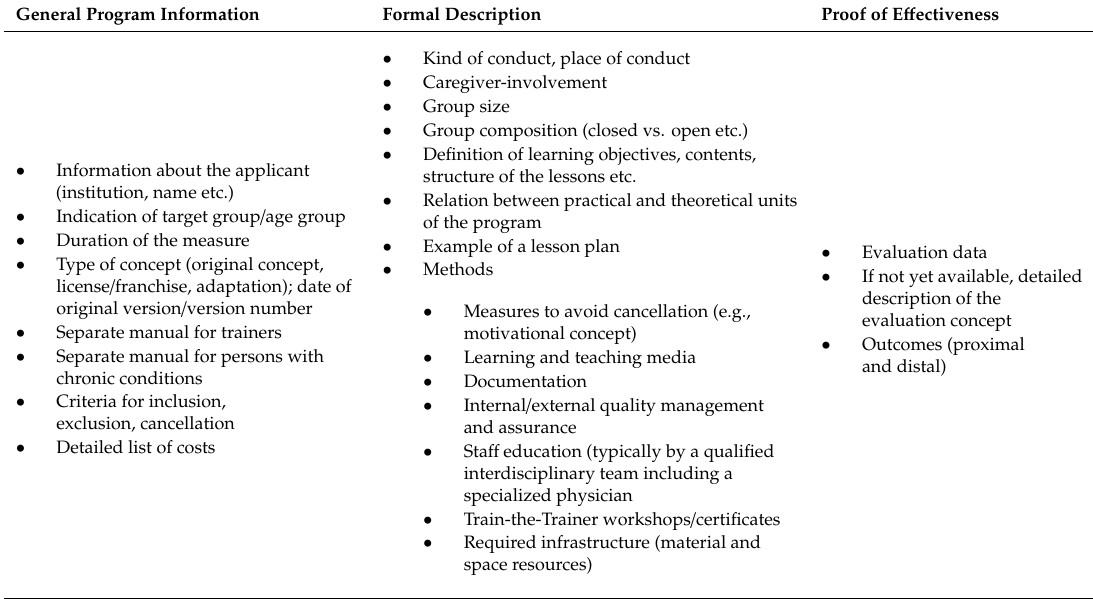
Table 4. Required documentation and information about the program to be certified